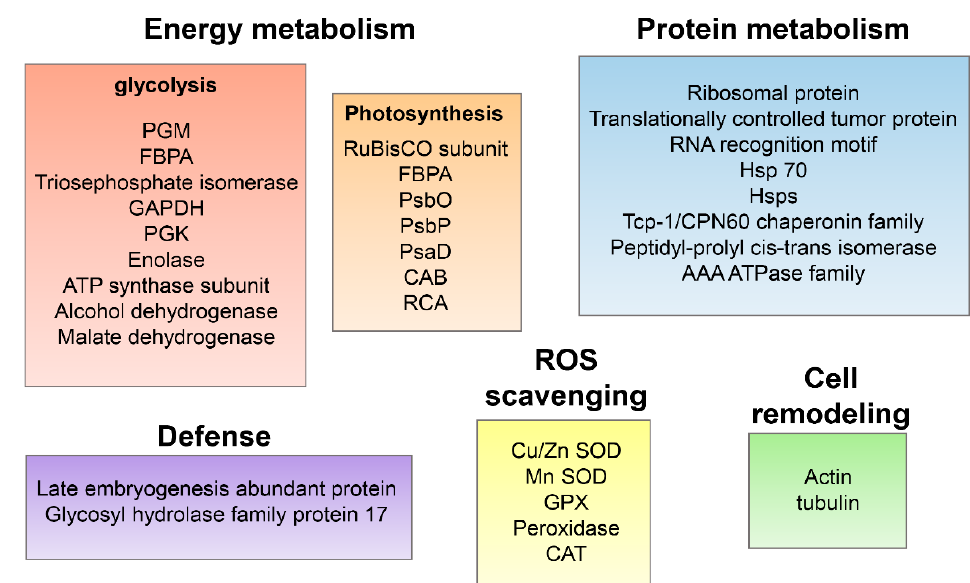
Figure 5. Salt-responsive proteins identified from fluid proteomic analysis. Identified proteins were classified according to the categories of energy metabolism, protein metabolism, cell reconstruction, ROS scavenging, and defense.